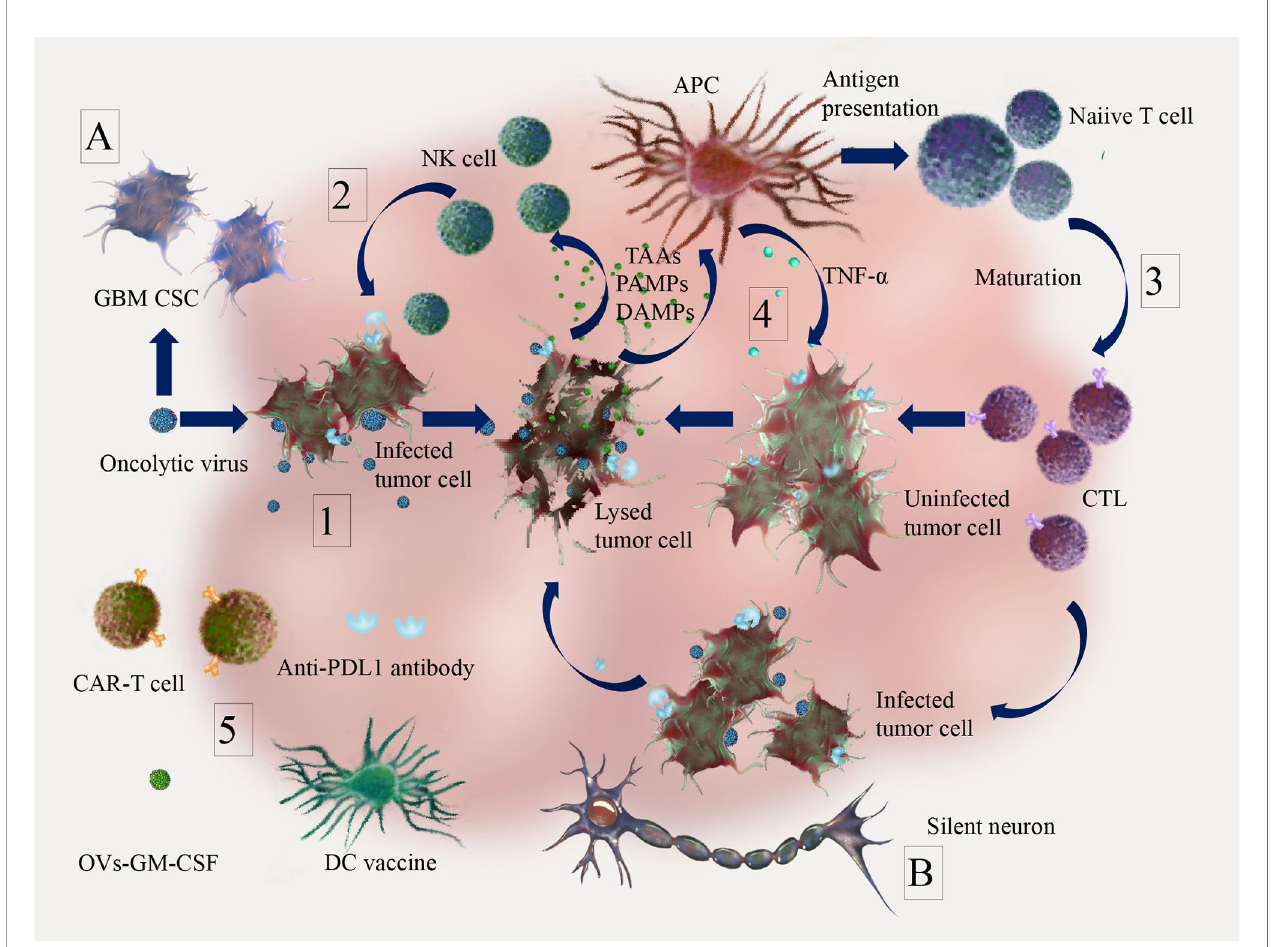
FIGURE 2 | Anti-tumor effects of oncolytic virus (OV) and combination therapy in brain tumor. 1. OVs can selectively or preferentially infect tumor cells and induce tumor lysis. 2. Innate immune response. Tumor cell lysis due to OVs infection can cause the release of tumor associated antigens (TAAs), cell-derived damage- associated molecular patterns (DAMPs) and viral pathogen-associated molecular patterns (PAMPs), which can recruit dendritic cells (DCs) and innate lymphoid cells (e.g. NK cells) for early clearance of virus-infected cells; 3. Adaptive immune response. The release of TAAs, DAMPs, PAMPs, pro-in fl ammatory cytokines and chemokines by lysed tumor cells can trigger activation of antigen presenting cells (APCs) and promote the priming of cellular mediated immune responses (CTL in fi ltration); 4. OVs infection leads to the release of TAAs, PAMPs and DAMPs, which can induce innate immune responses (e.g. secretion of TNF- a ) against not only infected tumor cells, but also uninfected tumor cells through bystander effects; 5. Infection and replication of oncolytic viruses in tumors can activate anti-tumor immunity and turn “ cold ” into “ hot ” tumors, which make combination therapies such as immune checkpoint inhibitors (e.g. PD-1/PD-L1 inhibitor), adoptive cell therapy (e.g. CAR-T), tumor vaccines (e.g. DC vaccine) and immunotherapeutic modulators (e.g. GM-CSF, which can enhance the activation of NK cells and CD8- mediated T cell response) more effective. For glioma speci fi cs, (A) antiviral innate immunity pathways (IFN pathway, TLR pathway) are reduced in glioblastoma cancer stem cells (GBM CSC), which contributes to the tumor cell speci fi city of OVs. (B) Due to the isolated location surrounded by mitotically silent normal neurons, malignant gliomas may be particularly suitable for treatment with OVs, which require active cell cycles for their